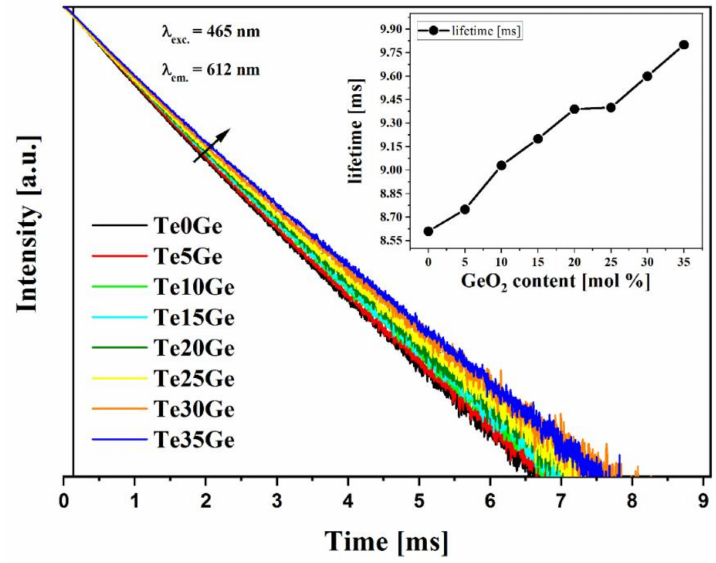
Figure 14. Luminescence decay curves of the 5 D 0 excited state of Eu 3+ ions in studied